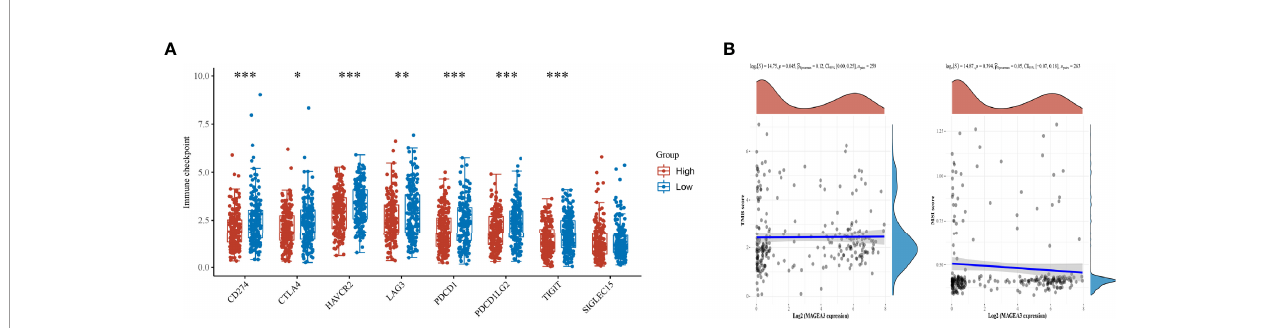
FIGURE 3 | Differential expression of immune checkpoints inMAGEA3 groups and correlations of MAGEA3 expression with TMB and MSI. (A) The expression distribution of Immune checkpoints related gene in MAGEA3 high group and MAGEA3 low group. (B) Correlation analysis of MAGEA3 gene expression and TMB, MSI. *p < 0.05; **p < 0.01; ***p